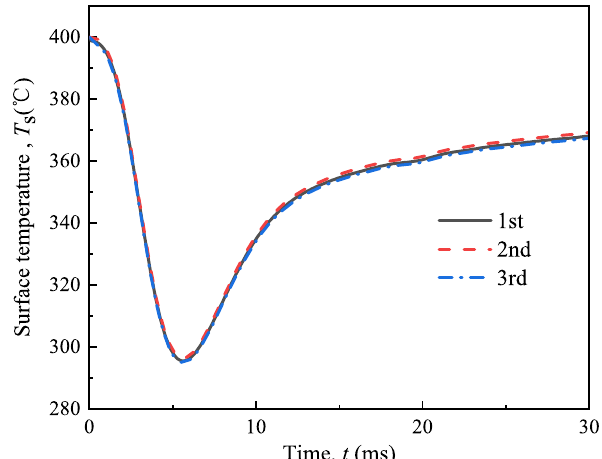
Figure 3. Three measurement results of the surface temperature ( T s ) under experimental conditions of T init = 400 °C, P inj = 160 MPa and T amb = 80